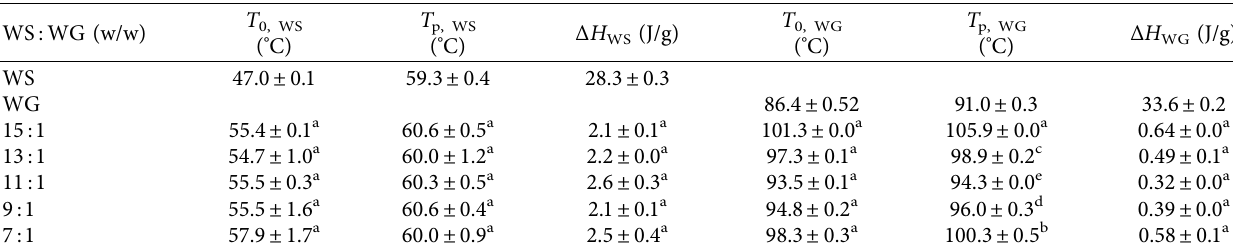
Table 3: Efect of the WS :WG ratios on the calorimetric parameters of batter (WS and WG represent wheat starch and wheat gluten, respectively; T 0, i and T p,i refer to the temperatures of starch gelatinization or protein denaturation required for the initial and maximum peak values, respectively, and Δ H i represents the amount of crystal melting during gelatinization for component i ; data are presented as mean value ± standard deviations from triplicate experiments ( n � 3); mean values listed in columns with diferent letters indicate statistically signifcant diferences ( p < 0 .